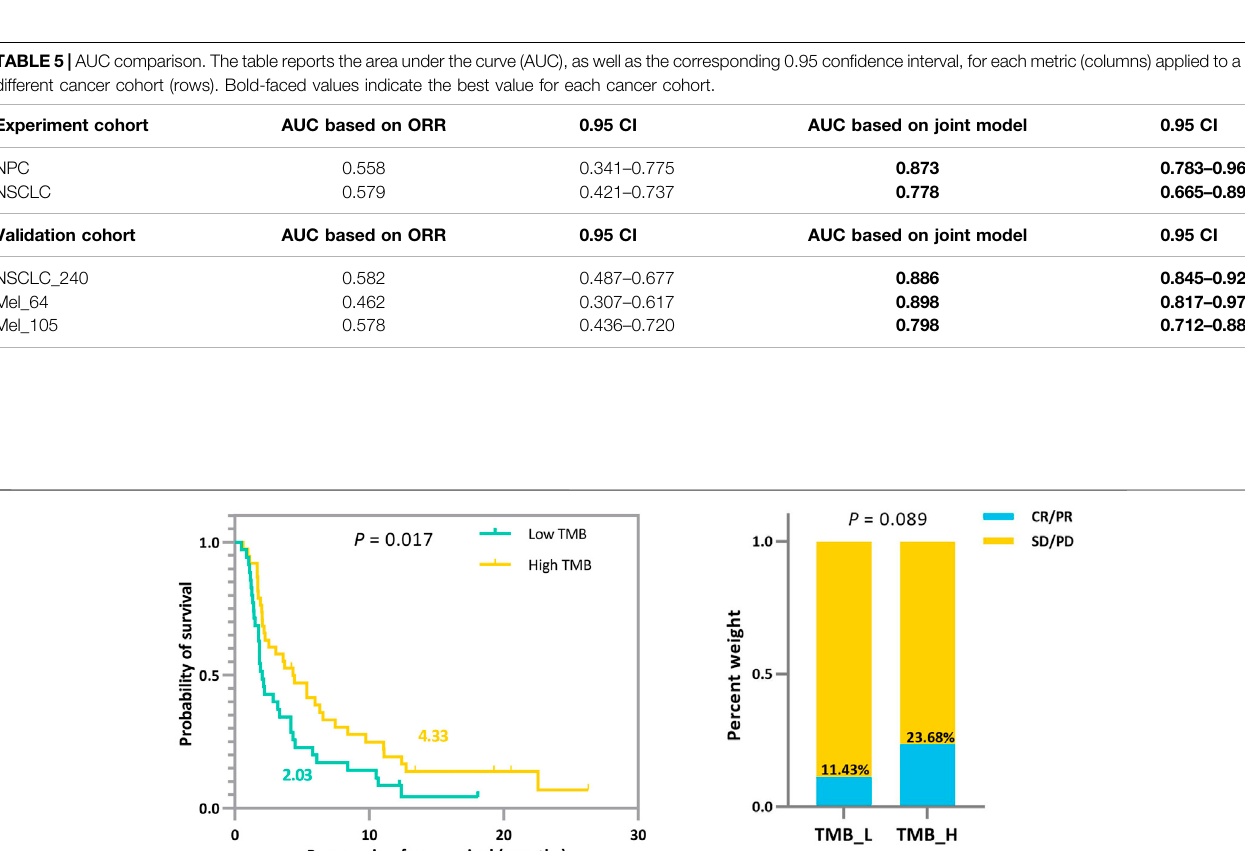
Frontiers in Genetics |